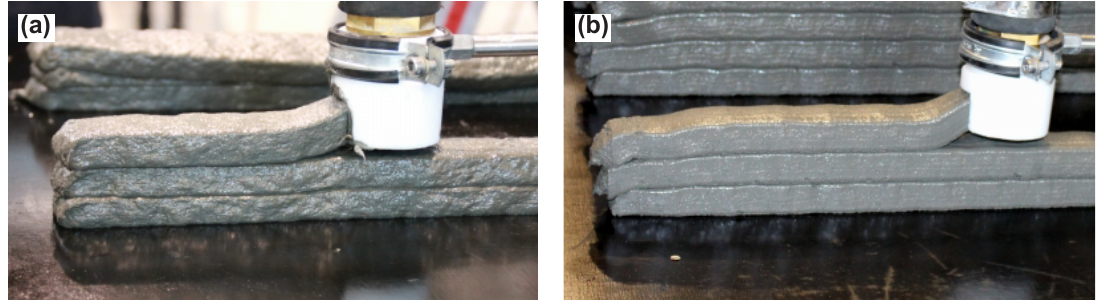
Figure 8. 3D-concrete-printing device placing ( a ) Mixture B and, for sake of comparison, ( b ) lightweight fine-grained